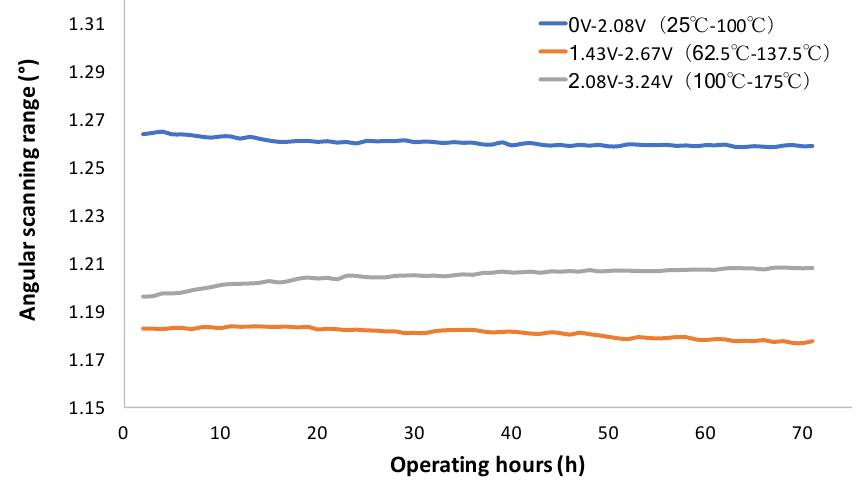
Figure 7. Mechanical scanning angle range of MEMS mirror driven by alternating current (AC) signals as a function of operating time.